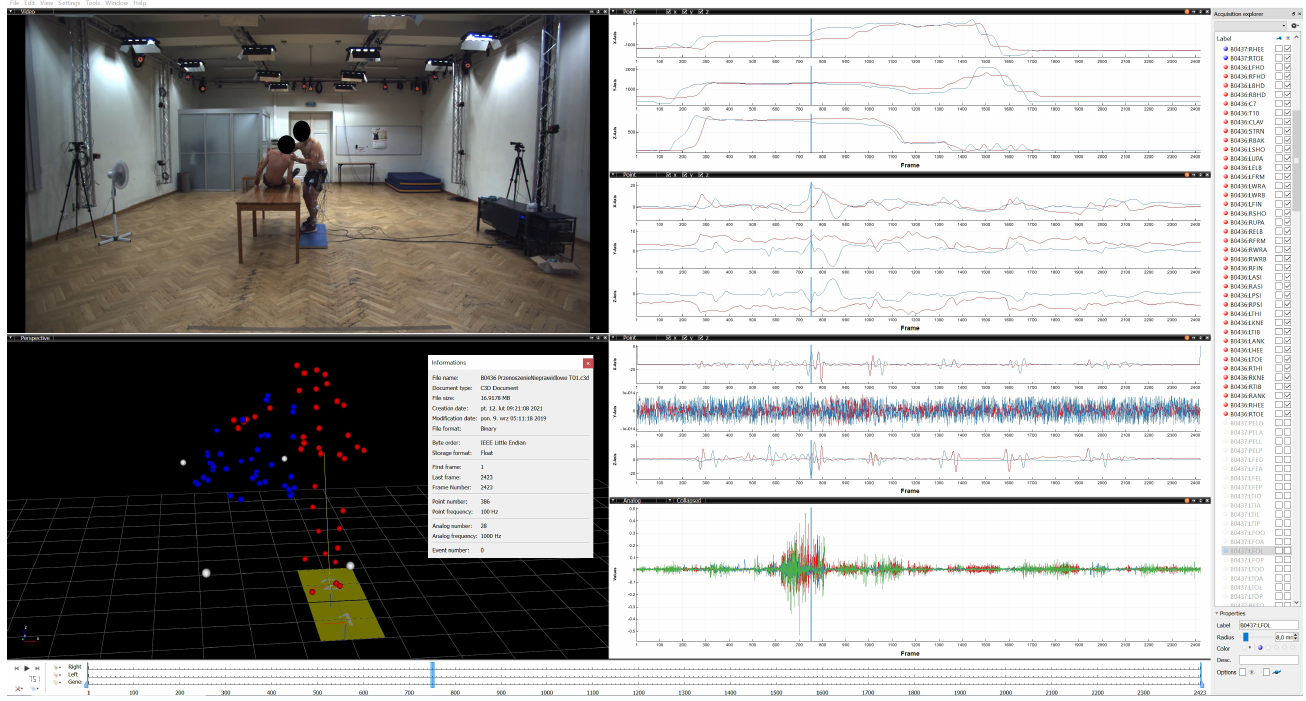
Figure 1. Visualization of the correct patient lifting with multimodal data (video, kinematics, kinetics, and